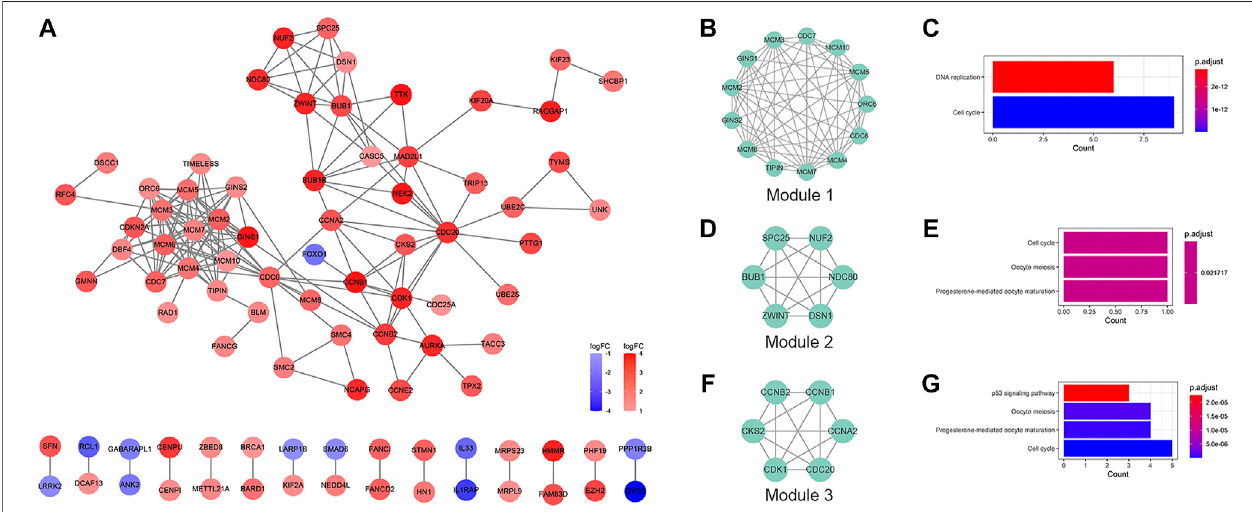
FIGURE4| PPInetworkandmoduleanalysis. (A) PPInetworkoftheDEGs.RedrepresentstheupregulatedDEGs,andbluerepresentsthedownregulatedDEGs. (B,D,F) TheselectedmodulesofthePPInetwork. (C,E,G) KEGGpathwayanalysisofthemodules.PPI,protein-proteininteraction;DEGs,differentiallyexpressedgenes; KEGG, Kyoto Encyclopedia of Genes and Genomes.